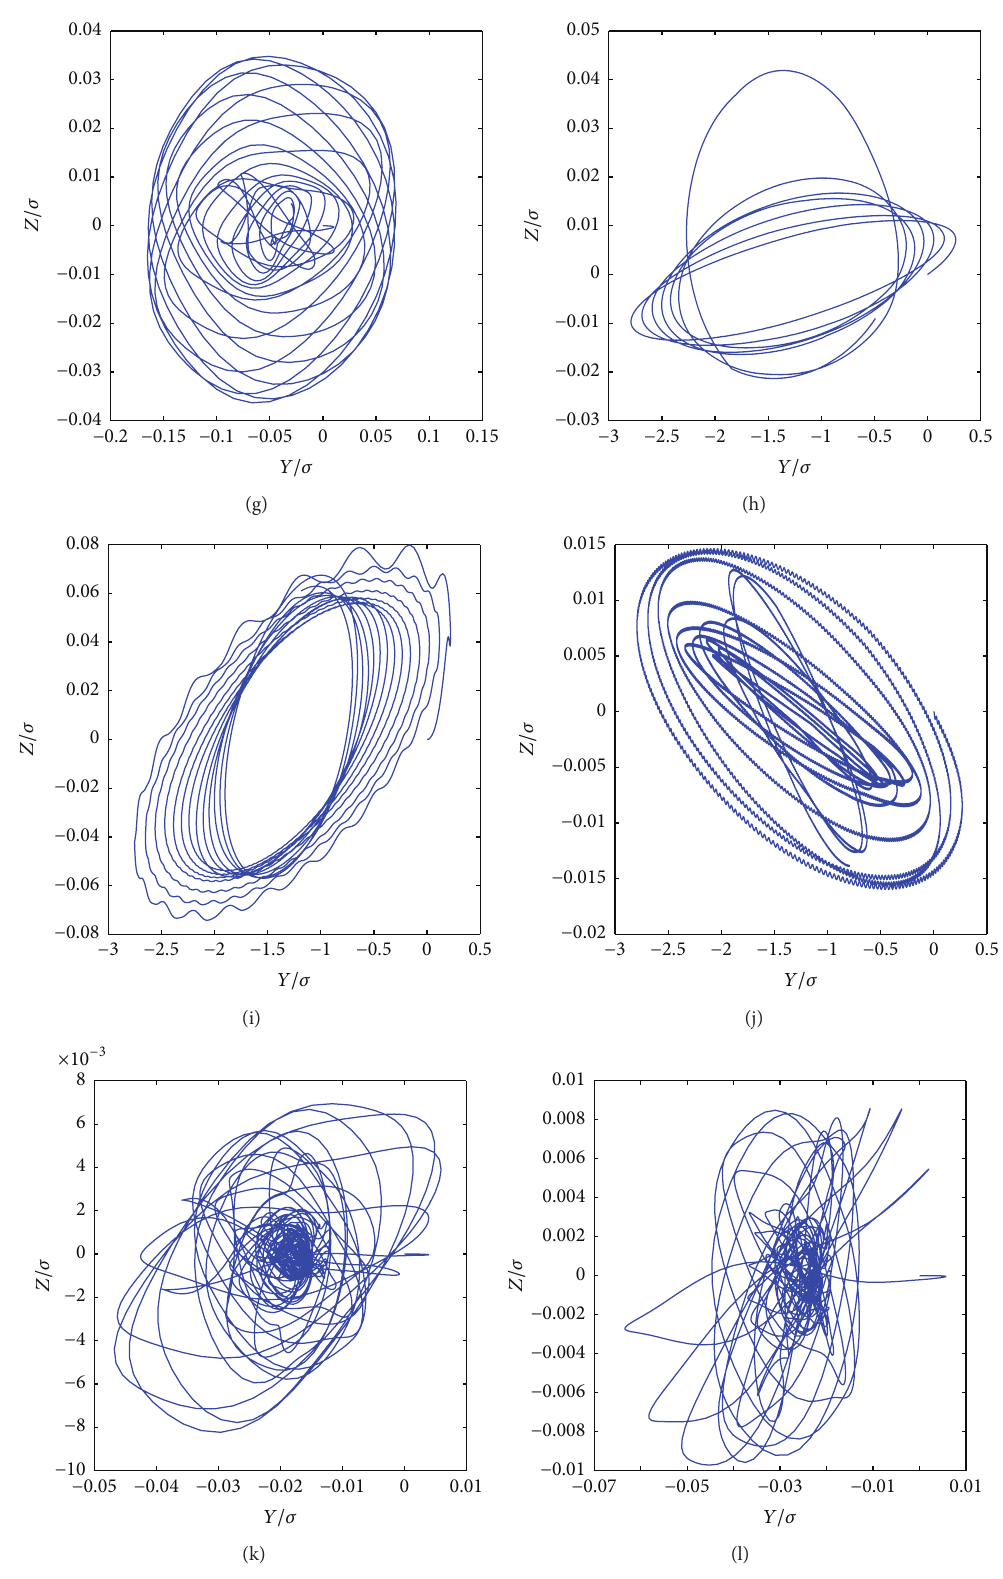
Figure 9: Orbit plots at different rotation speed ratio: (a) 𝑝 = 0 . 6015; (b) 𝑝 = 0 . 6018; (c); 𝑝 = 0 . 6529; (d) 𝑝 = 0 . 6531; (e) 𝑝 = 1 . 3570; (f) 𝑝 = 1 . 3573; (g) 𝑝 = 1 . 4576; (h) 𝑝 = 1 . 4578; (i) 𝑝 = 0 . 7570; (j) 𝑝 = 0 . 7882; (k) 𝑝 = 0 . 7919; (l) 𝑝 = 0 .